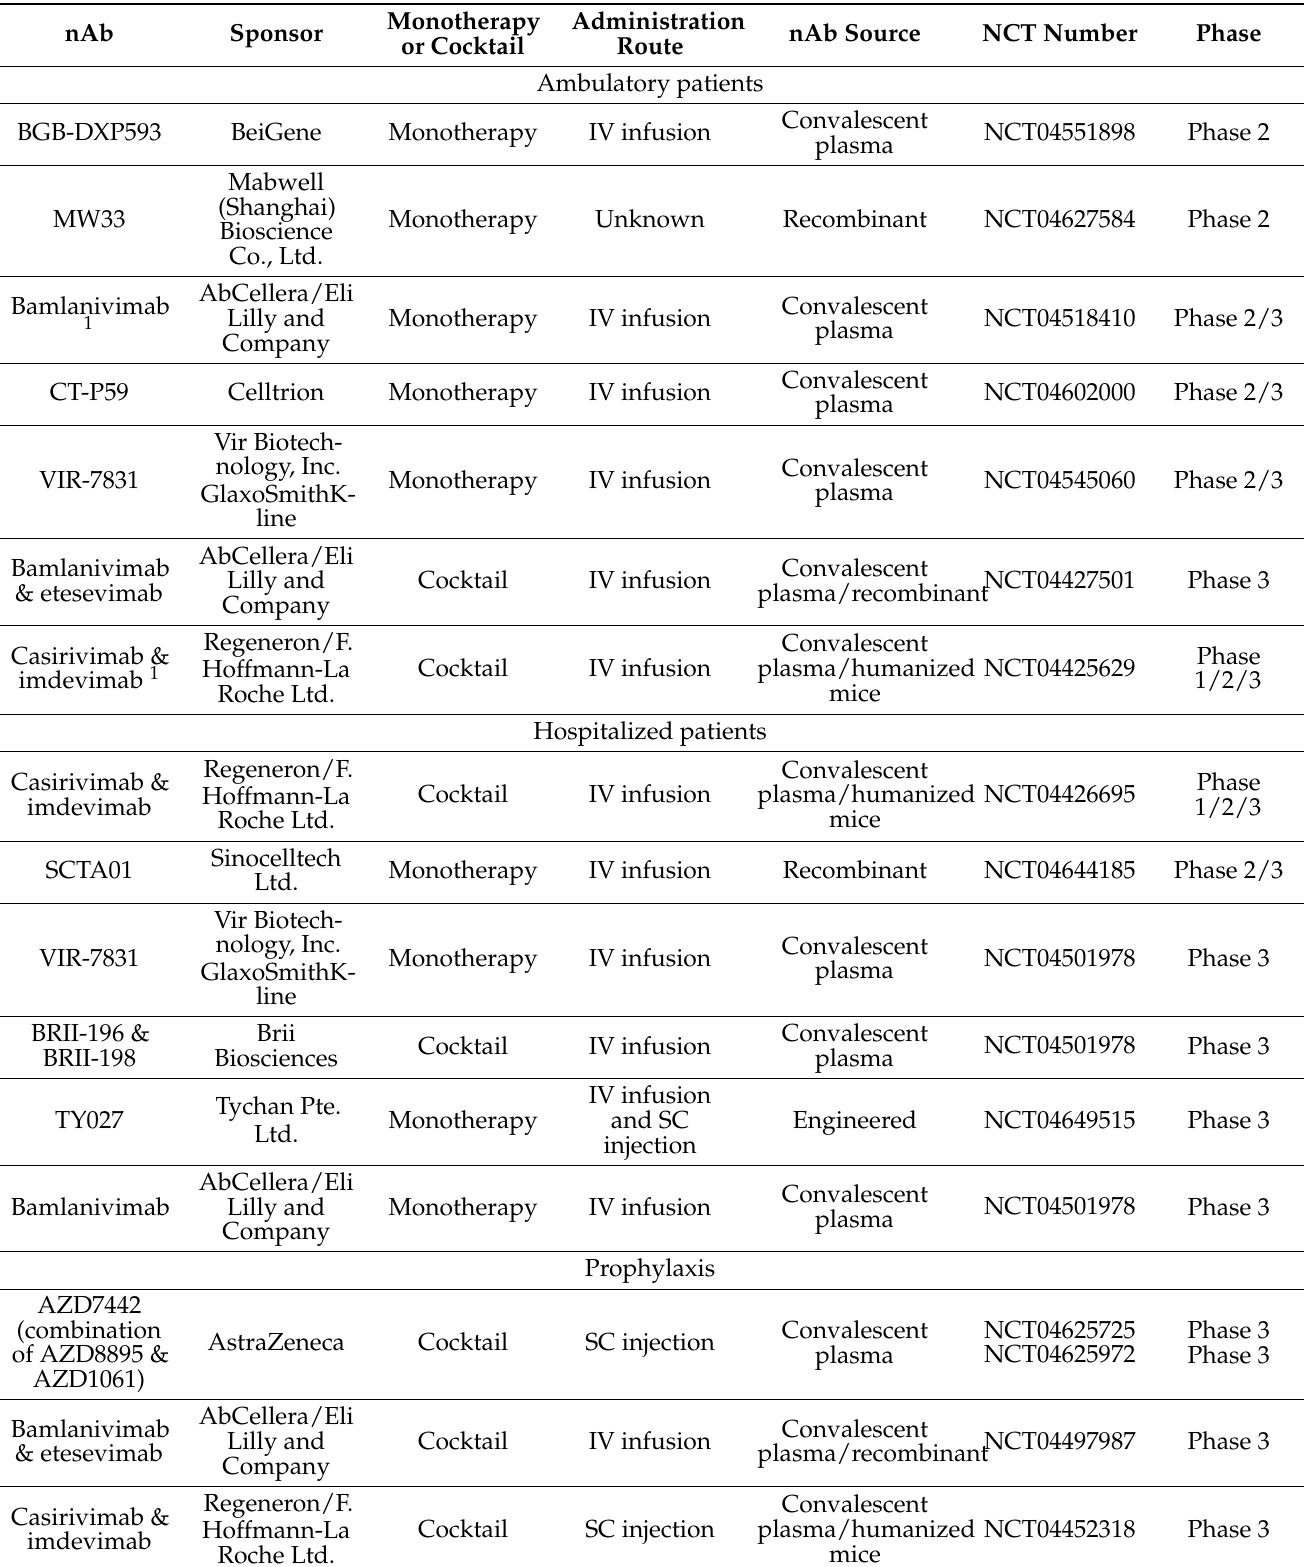
Table 1. Overview of Phase 2 or 3 Clinical Trials Evaluating Neutralizing Antibodies for COVID-19 Treatment or Prophylaxis.